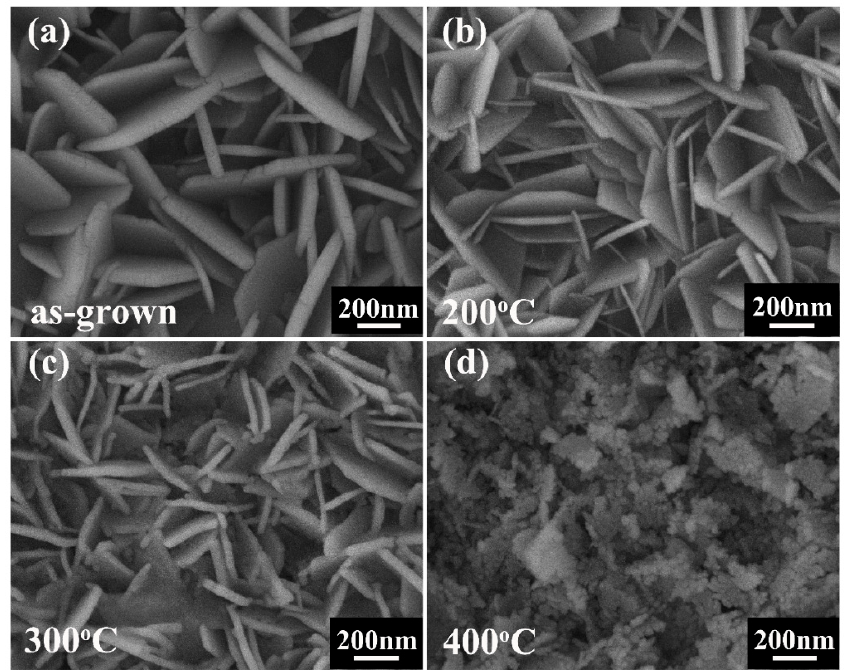
Figure 3. ( a ) The SEM image of the as-grown Cu 2 (NO 3 )(OH) 3 /ZnO NRs fabricated with 50 mM Cu2+ ion concentration and 20 min UV illumination time. ( b ) The SEM images of the Cu 2 (NO 3 )(OH) 3 /ZnO NRs annealed at 200 °C. ( c – d ) The SEM images of CuO/ZnO annealed at 300 °C and 400 °C,